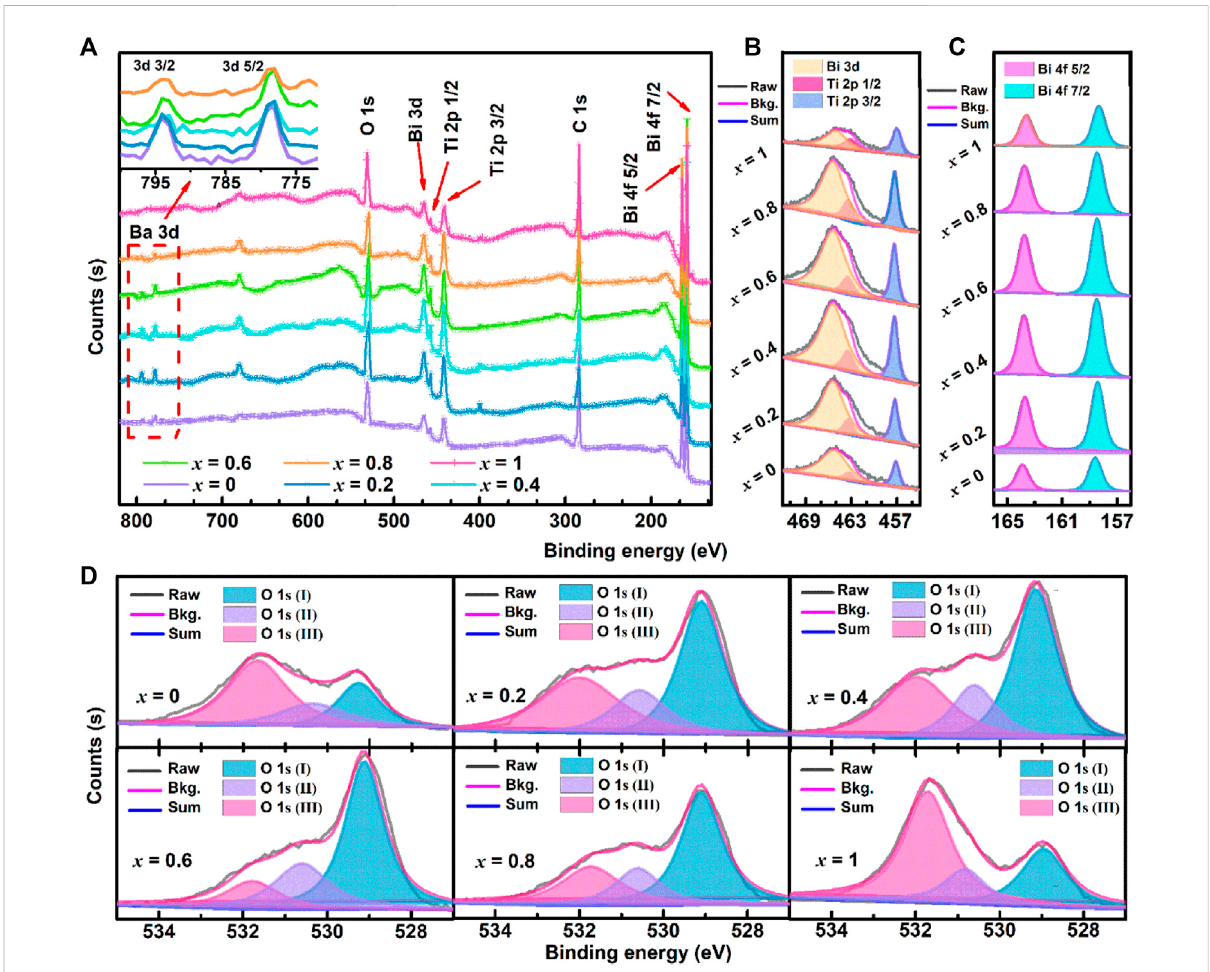
FIGURE 7 (Coloronline,Bkg.isshortforBackground)XPSspectrafor(1- x )BBT — x BiTceramicswithdifferentBiTcontent( x ): (A) ,XPSSurvey, (B) O1sscan, (C) Bi 4f scan, and (D) Bi 3 days and Ti 2p